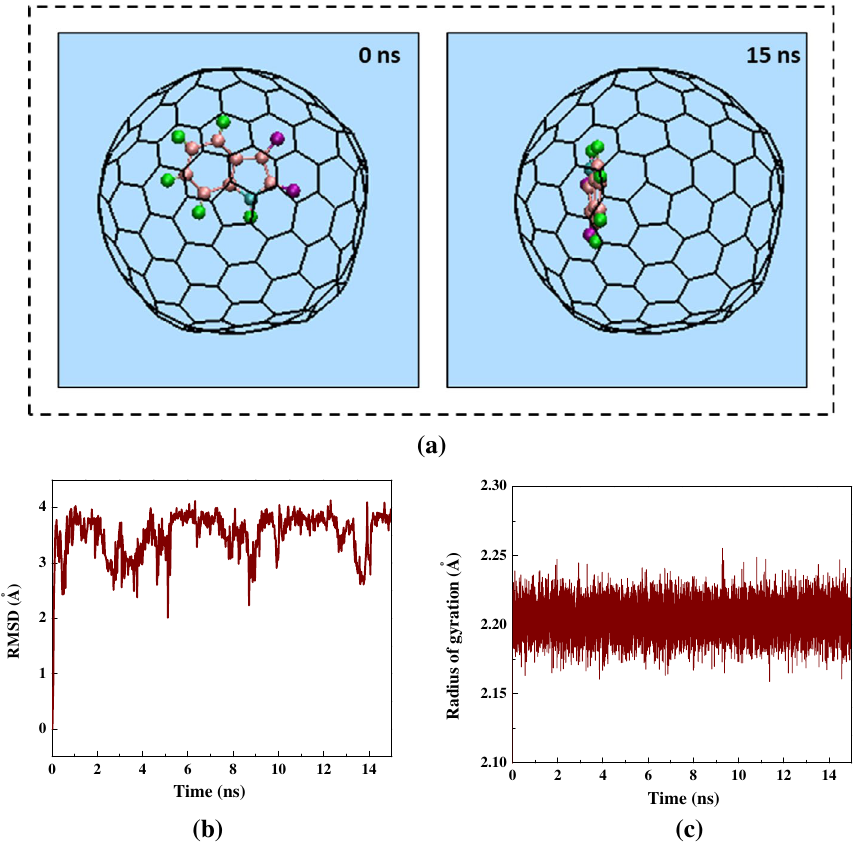
Figure 5. ( a ) Axial views of a single Isatin guest molecule at 0 ns and 15 ns in the MD simulation. For clarity, the water molecules have been omitted from the image. ( b ) The RMSD values of Isatin as shown as a function of simulation time. ( c ) Isatin radius gyration is shown as a function of simulation time in the capped SWCNT- Isatin complex.